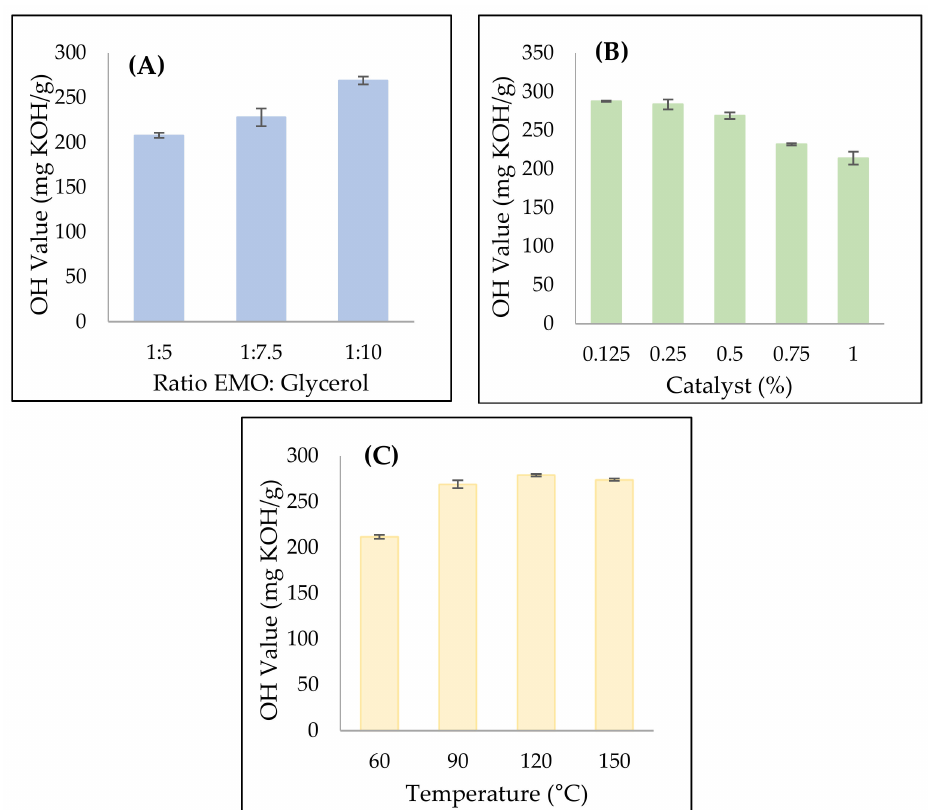
Figure 4. Effects of three factors on hydroxyl value. ( A ) Effect of mole ratio (EMO:Glycerol), ( B ) Effect of catalyst and ( C ) Effect of